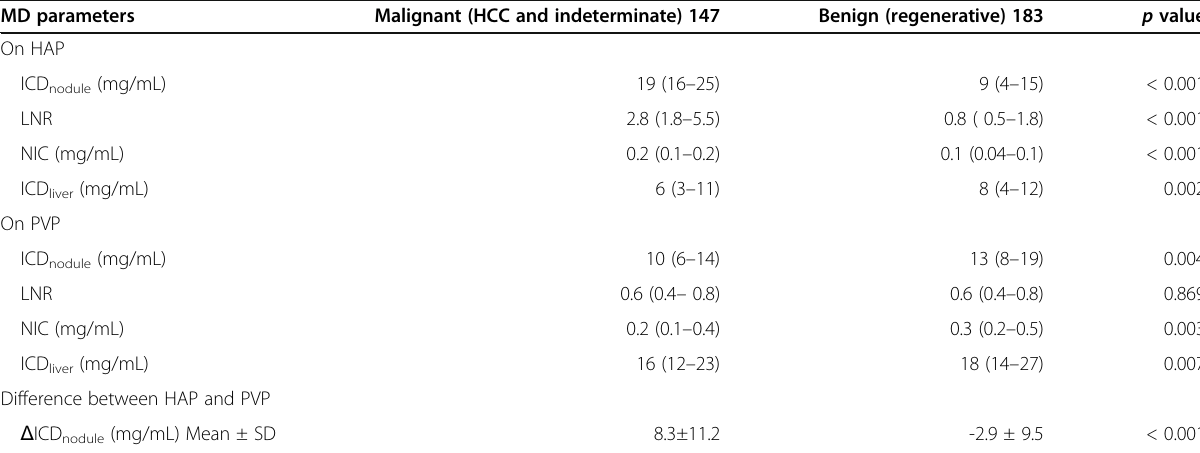
Table 4 Material density parameters of malignant and benign nodules on spectral computed tomography MD parameters